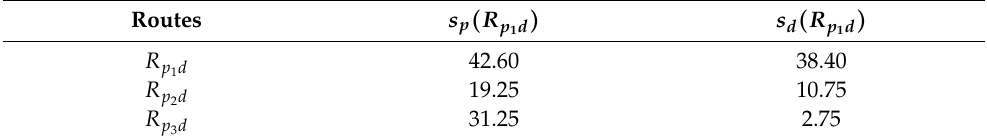
Table 3. The travel savings computed for passengers and driver through the joint route R pd .